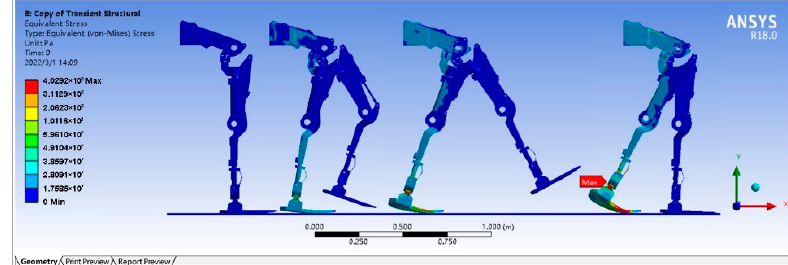
Figure 18. Stress simulation result of ANSYS.